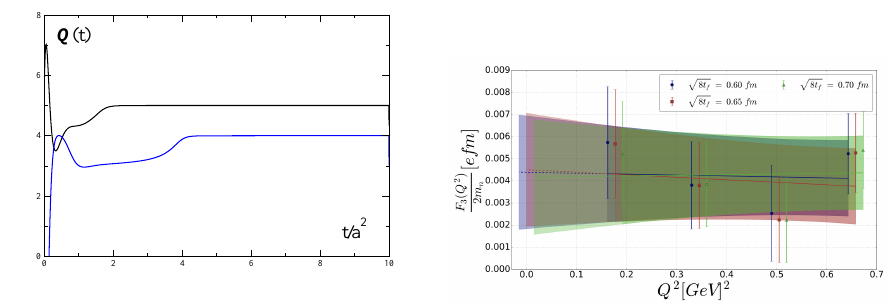
Figure 1. Left plot: Flow-time dependence of the topological charge on 2 SU(3) Yang-Mills gauge con- figurations. Right plot: Dependence of the nucleon CP-odd form factor on the momentum transfer Q 2 for a pion mass of m π (cid:39) 410 MeV. The di ff erent colors correspond to the di ff erent flow times used to evaluate the topological